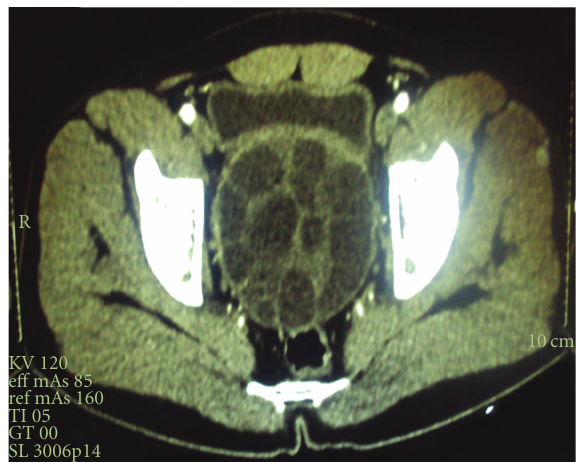
Figure 1: CT showing a pelvic multiloculated hydatid cyst.